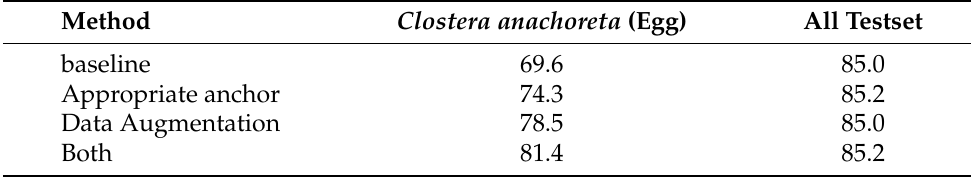
Table 7. mAP of weak subclass and all testset with / without improvement.